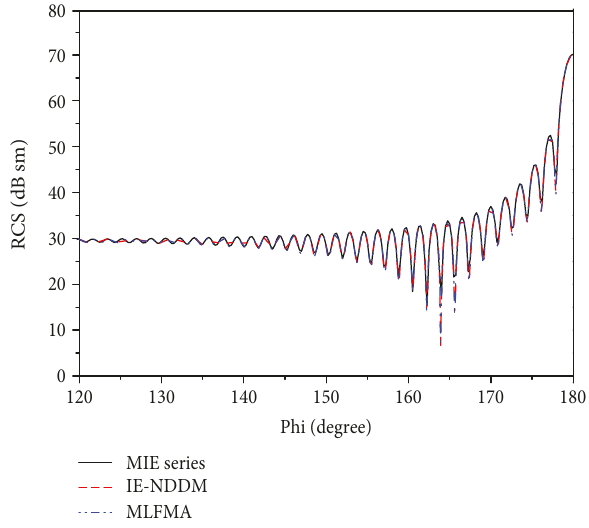
Figure 6: HH-polarized bistatic RCS in the xoy plane with the incident angle theta = 90 degree and phi = 0 degree.